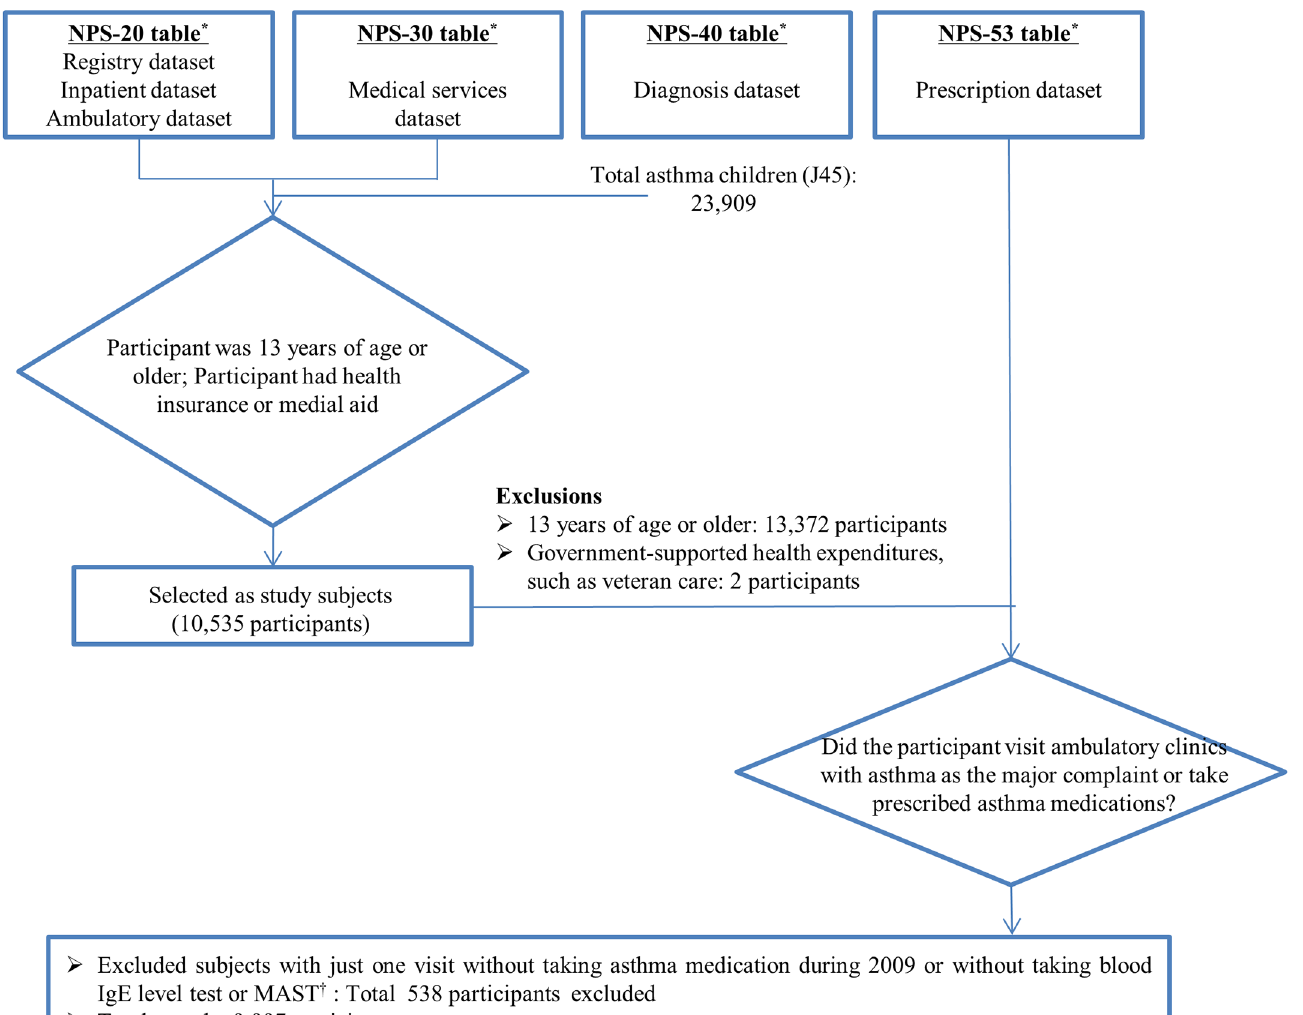
Fig 1. Flowchart of study participant selection. * , The National Health Insurance claims data consisted of 4 tables (20, 30, 40, and 53 table). Each table includes different information. † , MAST; multiple radioallergosorbent test.